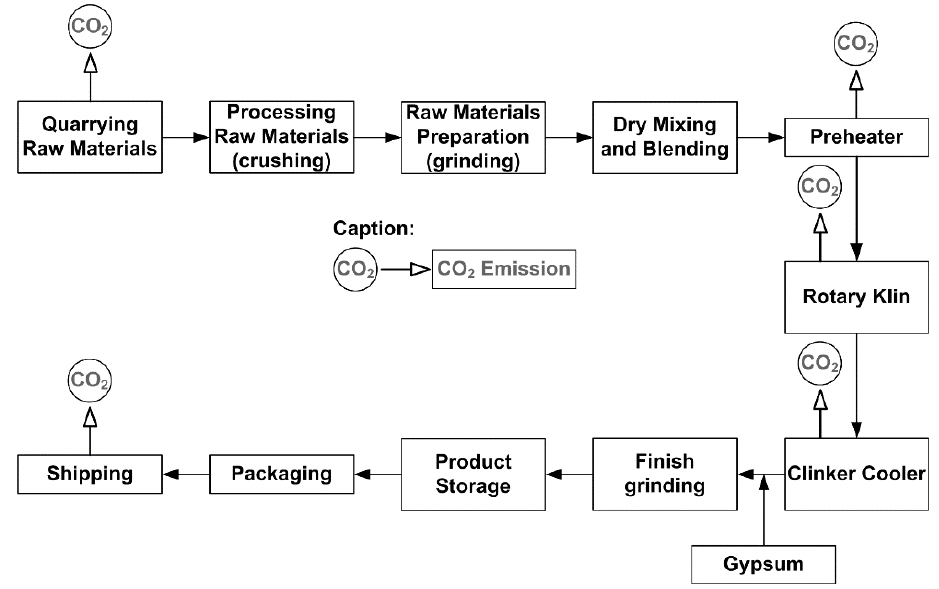
Figure 2. Detailed diagram showing the steps of OPC manufacturing and stages during which CO 2 is emitted